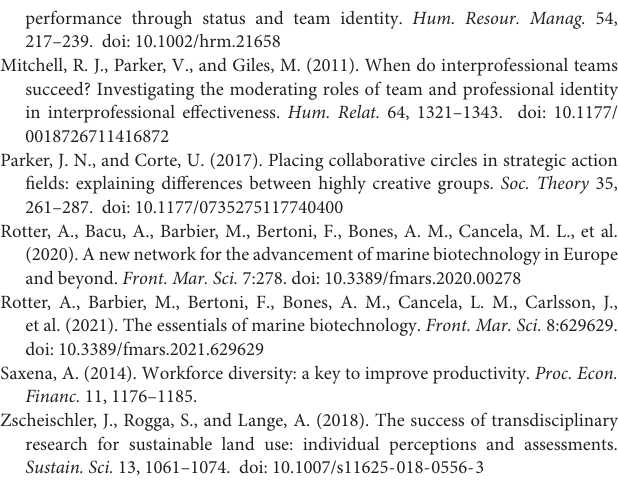
Supplementary Figure 1 | Representation of expertise fields from the marine biotechnology experts that filled in the inquiry. The pie area represents the percentage of expertise covered. Note that the respondents could select more than one expertise to allow transdisciplinary experts to showcase their